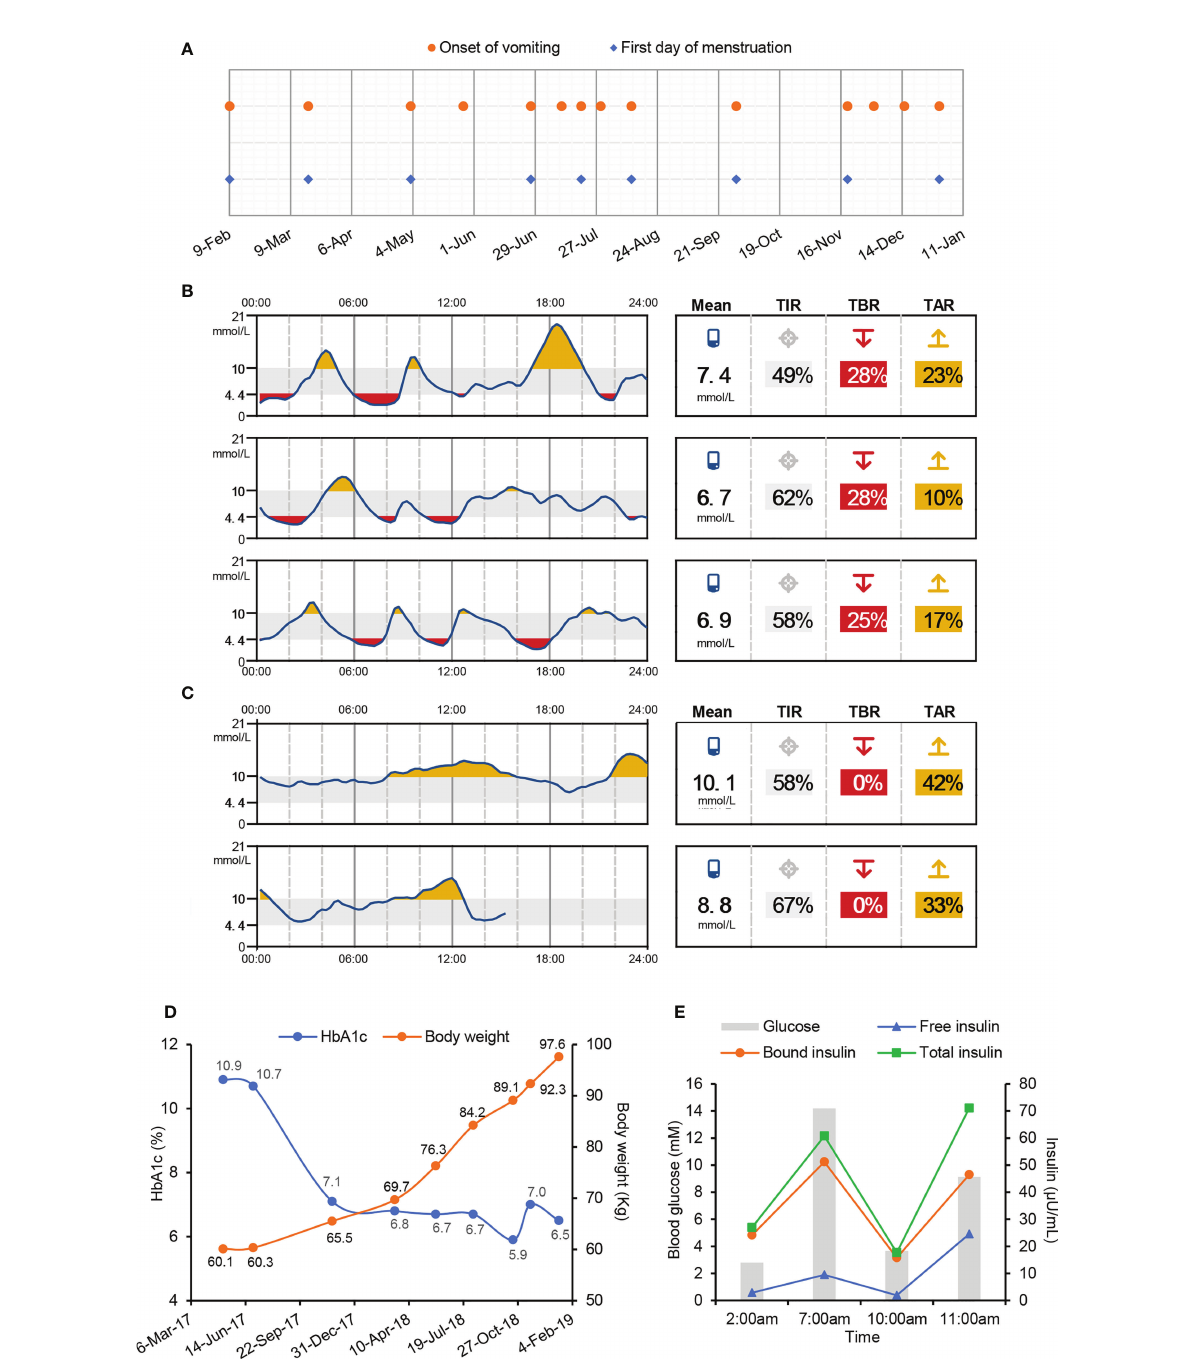
FIGURE 1 Symptoms of cyclic vomiting and intractable hypoglycaemia in this T1D patient. (A) Date of vomiting onset and the fi rst day of menstruation. (B, C) Continuous blood glucose monitoring after the remission of vomiting (B) and before discharge (C) during one hospital stay by Abbott Freestyle Libre Flash Glucose Monitoring System. TIR, time in range. TBR, time below range. TAR, time above range. (D) Body weight and HbA1c levels after suffering from hypoglycaemia. (E) Blood glucose and serum insulin levels during overnight fasting and refeeding